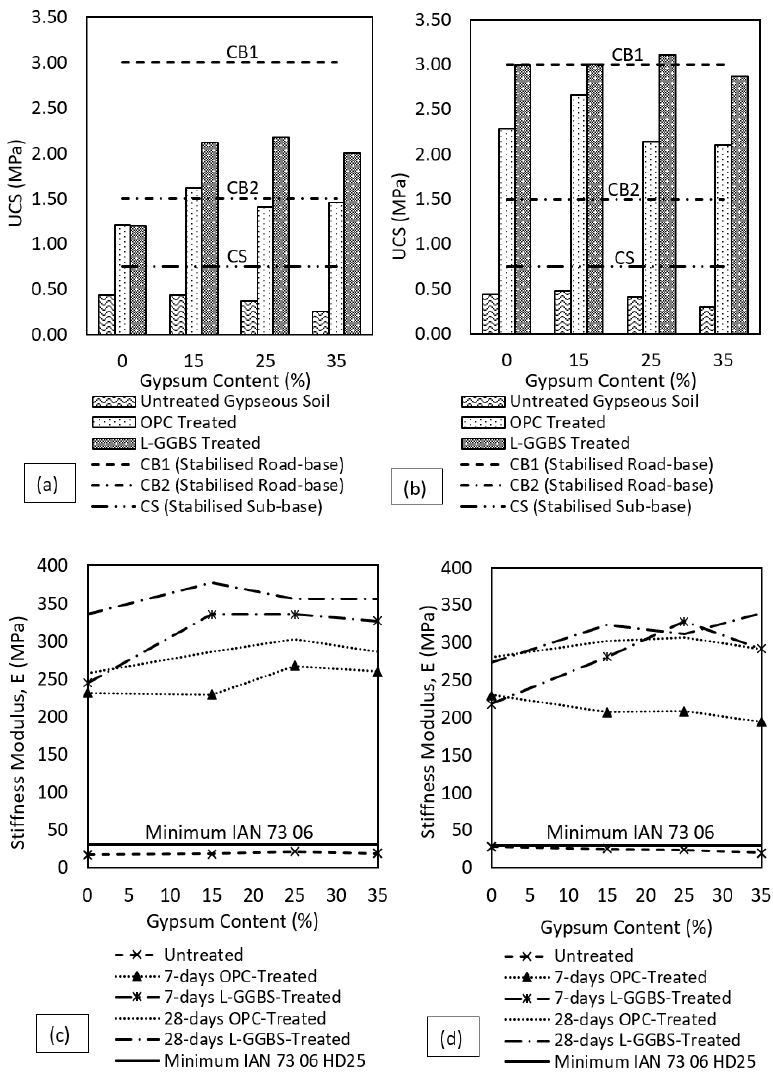
Figure 8. UCS of OPC and LG treated gypseous soils. ( a ) 7-days cured. ( b ) 28-days cured. ( c ) Soaked stiffness modulus. ( d ) Unsoaked stiffness modulus.